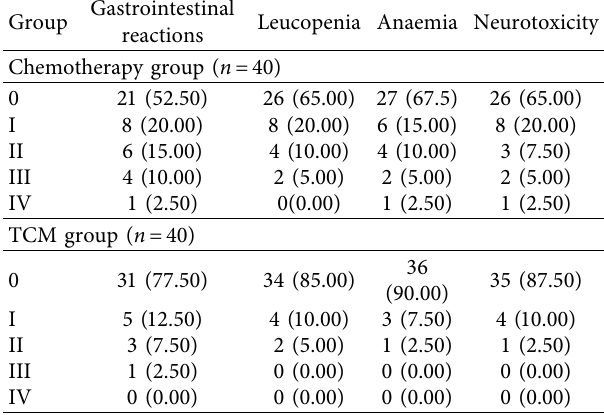
Table 3: Comparison of toxic side effects between the two groups ( n ,